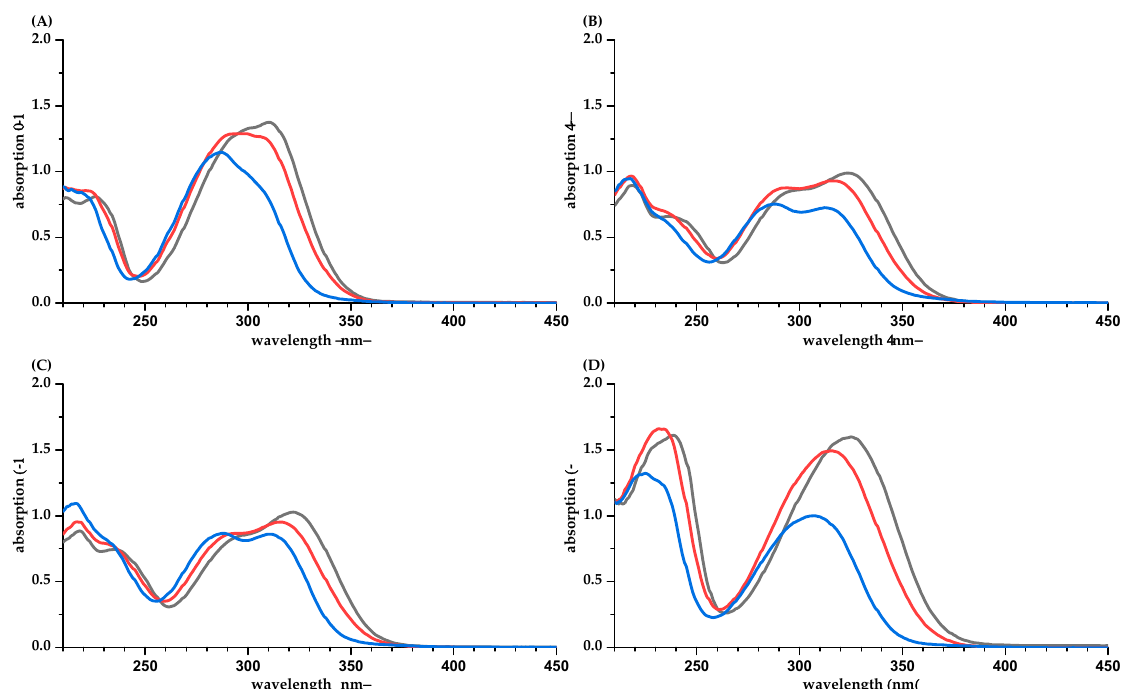
Figure 2. UV spectra of hydroxycinnamic acids in water/methanol (50/50, v/v , black), water (red), and phosphate buffer pH 7.5 (blue). ( A ), coumaric acid; ( B ), caffeic acid; ( C ), ferulic acid; ( D ), sinapinic acid. Concentrations are different for the four hydroxycinnamic acids but similar among the